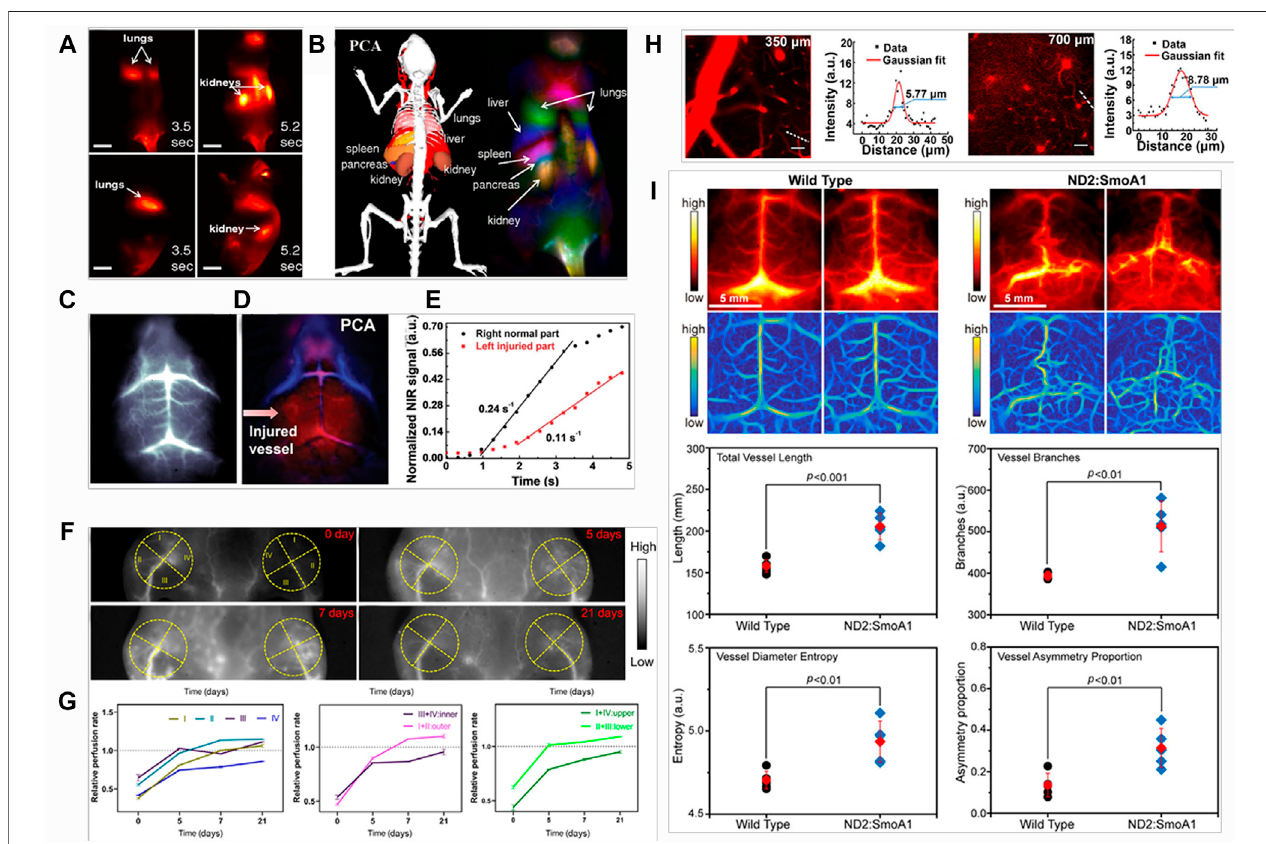
FIGURE 4 | Examples of NIR-II fl uorescence imaging for in vivo quantitative analysis. (A) Frames from video imaging of mice injected with NIR-II fl uorophore SWNTs. (B) Dynamic contrast-enhanced imaging with SWNTs through PCA. This feature is not observable in the raw time-course images (reproduced from (Welsher et al., 2011)with permission from National Academy of Sciences.). (C) Dynamic brain imaging of stroke mouse. (D) PCA overlaid images with arterial (red) and venous (blue) vessels of stroke mouse, indicating more signi fi cant injured signal in the left brain. (E) Blood perfusion of stroke mouse, showing slower blood fl ow in the injuredleftbrainthanthehealthrightbrain.Errorsbarsindicatethestandarddeviationofeachgroup(reproducedfrom(Liuetal.,2019)withpermissionfromWILEY-VCH Verlag GmbH and Co. KGaA, Weinheim.). (F) NIR-II fl uorescence images of hindlimb vessels at 0, 5, 7 and 21 days postischemia. (G) The relative perfusion rate of four quadrants, upper and lower quadrants, inner and outer quadrants (reproduced from (Chen et al., 2020)with permission from Tsinghua University Press and Springer- Verlag GmbH Germany, part of Springer Nature). (H) In vivo NIR-II fl uorescence confocal scanning microscopic images of mouse brain vasculature at 350 and 700 μ m depth,andtheGaussian fi tstothepro fi lesalongthecapillaryvesselsindicatedbythewhite-dashedlines(reproducedfrom(Yuetal.,2019)withpermissionfromElsevier B.V.andScienceChinaPress.). (I) Invivo NIR-II fl uorescenceimages (toppanel) andHessian-matrix-enhancedimages (bottompanel) ofcerebralvasculatureofwild- type C57BL/6 mice and ND2:SmoA1 mice (n (cid:1) 5). Red data are reported as mean: standard deviation (reproduced from with permission (Liu et al., 2020c)from Wiley- VCH